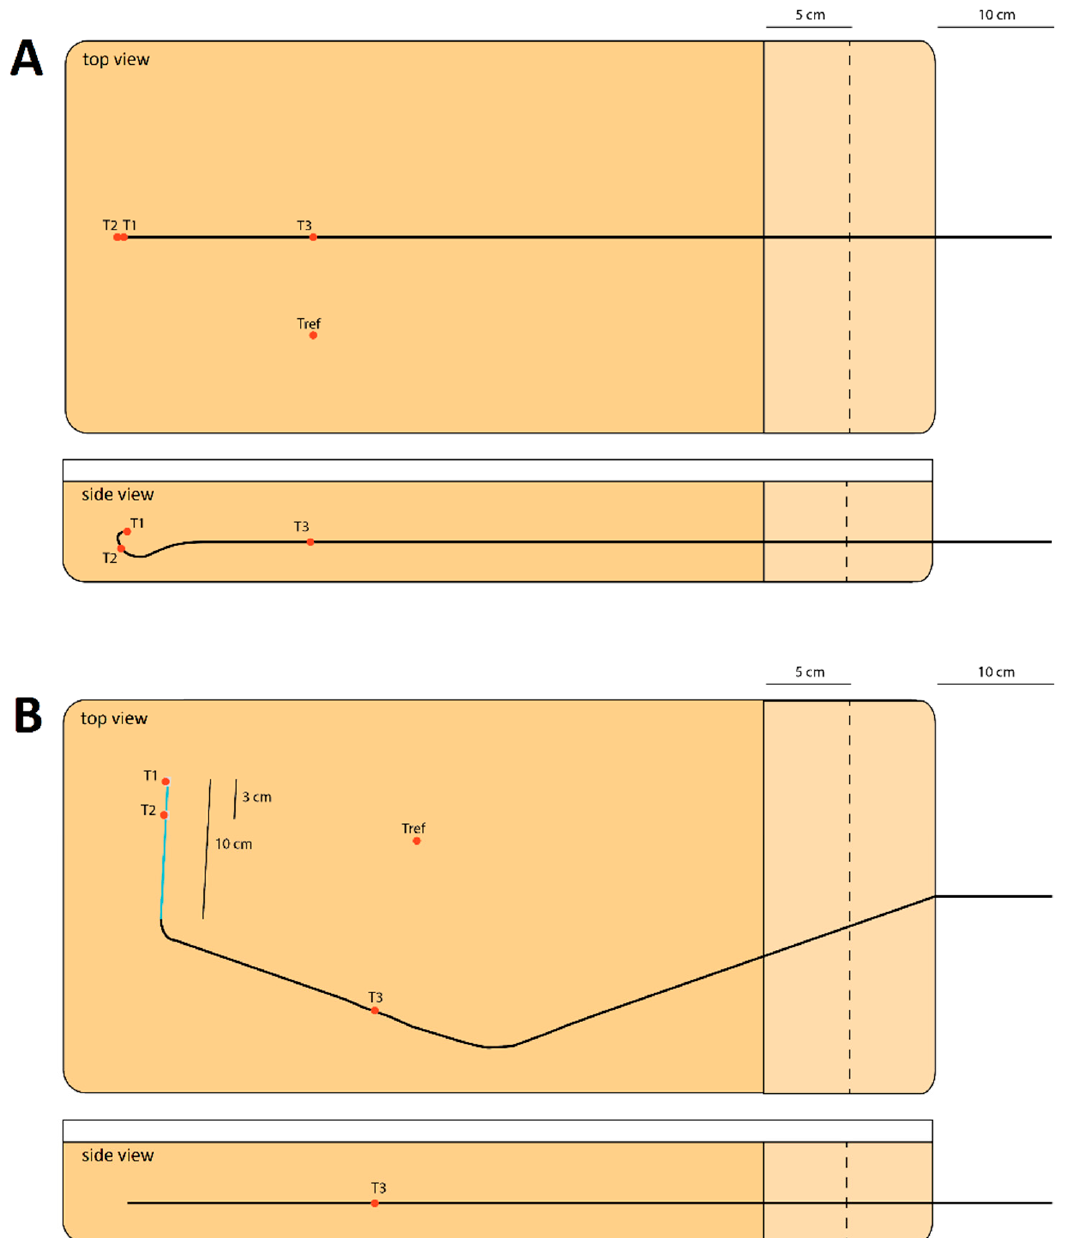
Figure 1. A schematic overview of the agarose phantoms that were cast to investigate the MR safety in guiding catheter A ( A ) and the microcatheter inserted in guiding catheter A ( B ). The black line resembles guiding catheter A, the blue line resembles the microcatheter, and the red dots resemble the temperature probes. In ( A ), probe 1 (T1) is located at the tip of the catheter, probe 2 (T2) midway in the C-shaped curve and probe 3 (T3) along the straight, more proximal part. In ( B ), T1 is located at the tip of the microcatheter, T2 at a marker 3 cm proximal from the tip and T3 along the straight part of guiding catheter A. Tref is a reference temperature probe. After all initial measurements, a 5 cm-wide block of agarose was removed twice near the proximal end of the catheter, after which all measurements were repeated.